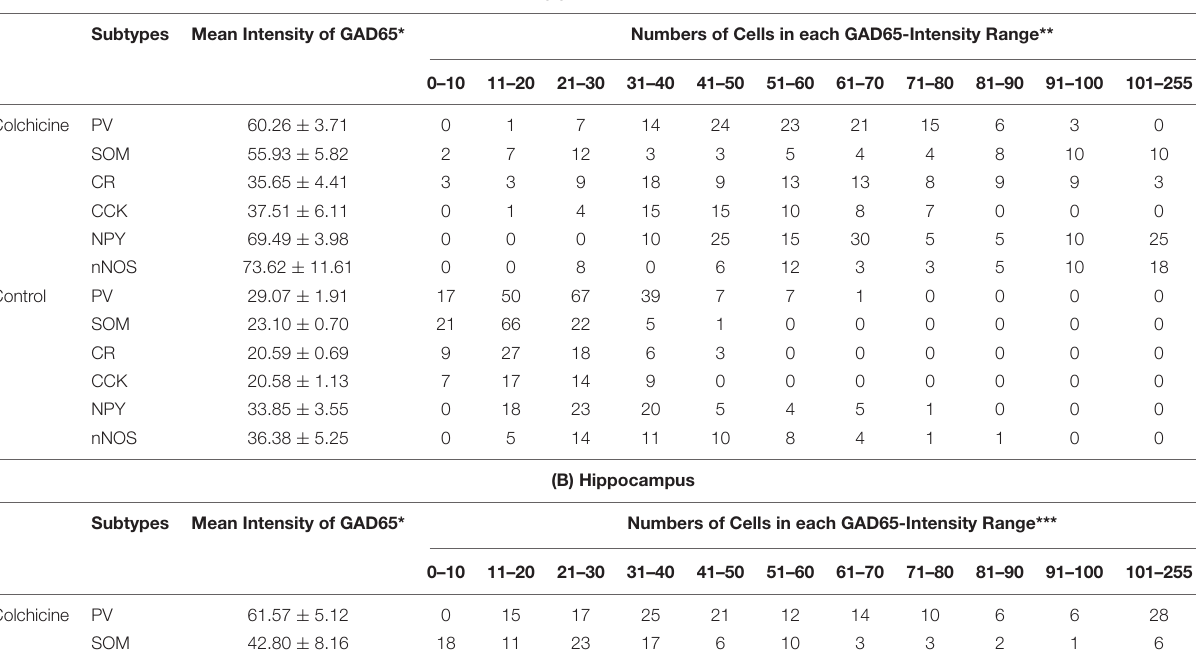
TABLE 3 | GAD65 Expression in (A) Cerebral Cortical (B) Hippocampal layers based on GAD65 staining intensity in colchicine-injected rats. (A) Cerebral Cortex Subtypes Mean Intensity of